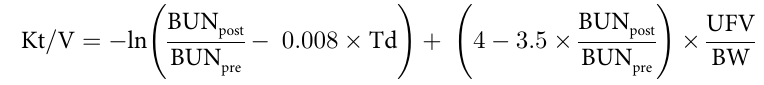
a Vascular access, blood flow rate, dialysate flow rate, membrane type and membrane area at clinical condition was more than 10% of the total population in the paper. b Dialysis time at clinical condition was more than 5% of the total population in the